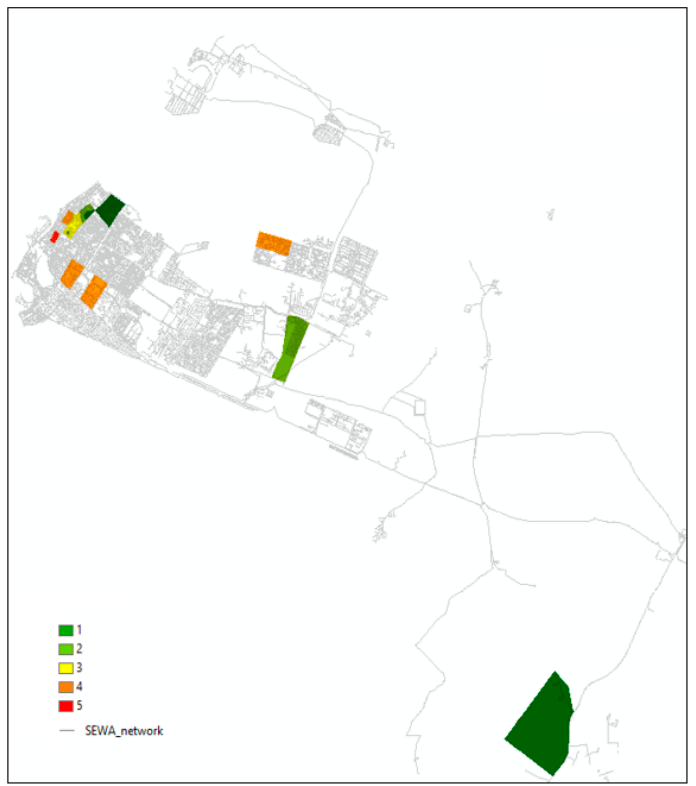
Figure 4. Physical parameters; fittings per length map.